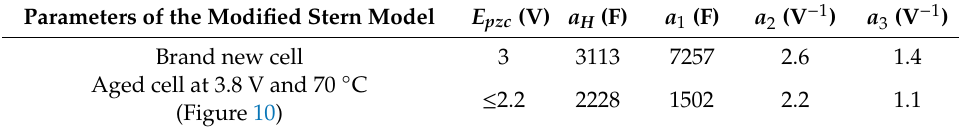
Table 3. Comparison of the C(V) model parameters before and after aging at 3.8 V and 70 ◦ C for 17